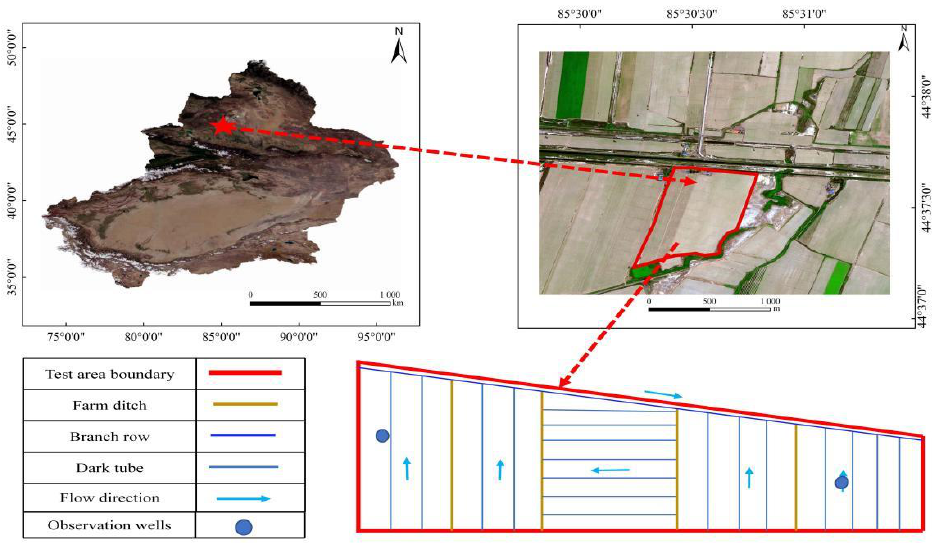
Figure 1. Location of the test